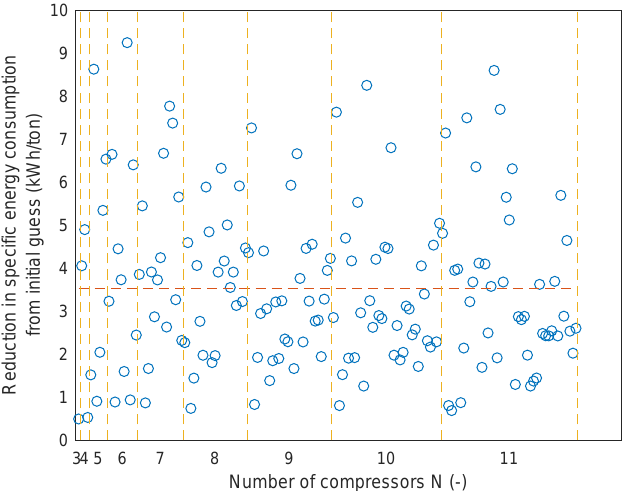
Figure 6. Reduction in specific energy usage when optimizing evenly distributed temperature levels for all modeled cases shown in Figure 7.